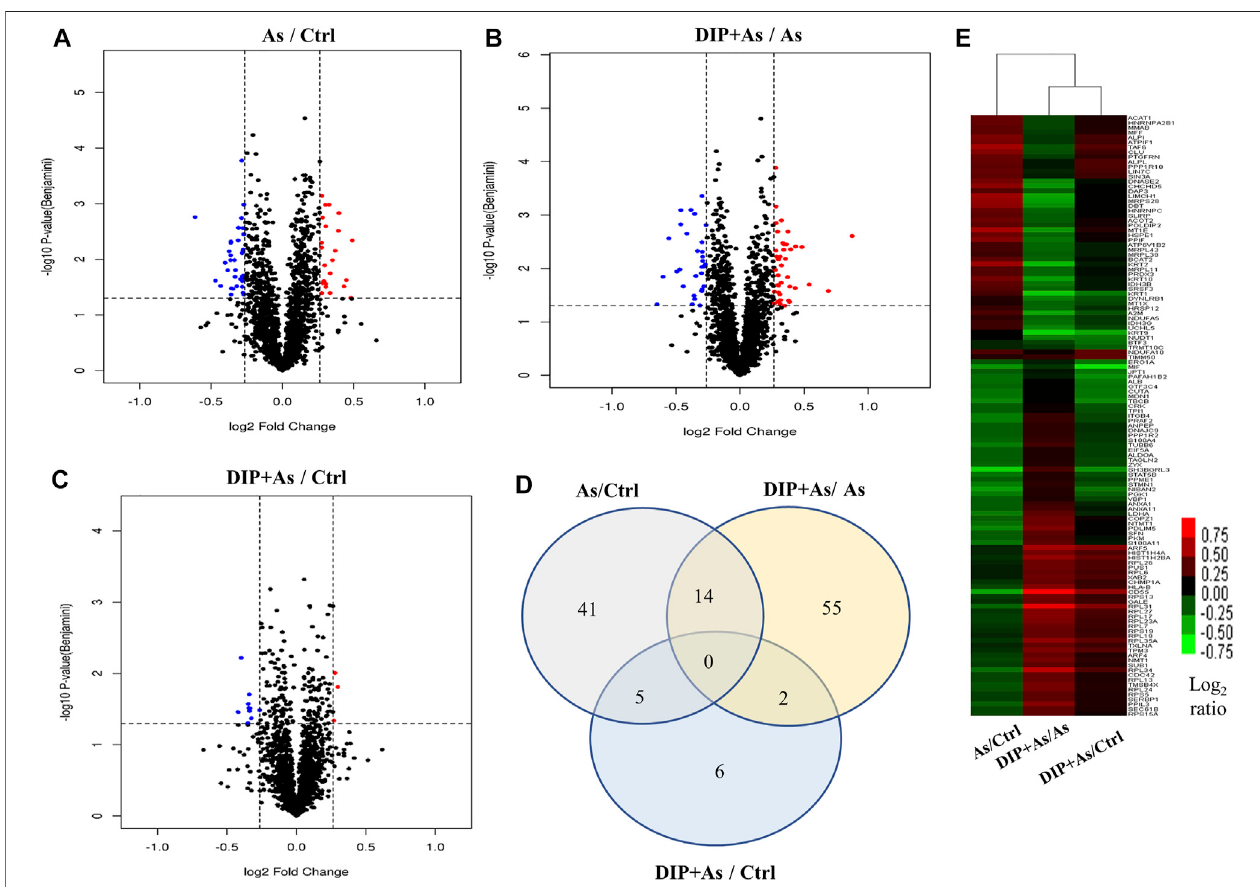
FIGURE 2 | The differentially expressed proteins identi fi ed in different groups. (A) Volcano plots depicted the distribution of proteins in As/Ctrl group. (B) Volcano plots depicted the distribution of proteins in DIP + As/As group. (C) Volcano plots depicted the distribution of proteins in DIP + As/Ctrl group. (D) Venn diagrams of DEPs between the As/Ctrl group, DIP + As/As group, and DIP + As/Ctrl group. (E) Cluster map comparing the DEPs identi fi ed in As/Ctrl, DIP + As/As, and DIP + As/Ctrl groups. Red color indicates higher expression, green indicates lower expression, and black indicates similar expression levels. (A – C) : The log 2 fold change(FC) is plotted versus the – log 10 ofthe p -value (Benjamini). Red dots (cid:2) hits with p < 0.05and mean log 2 FC > 0.83; bluedots (cid:2) hitswith p < 0.05 and means |log 2 FC| <